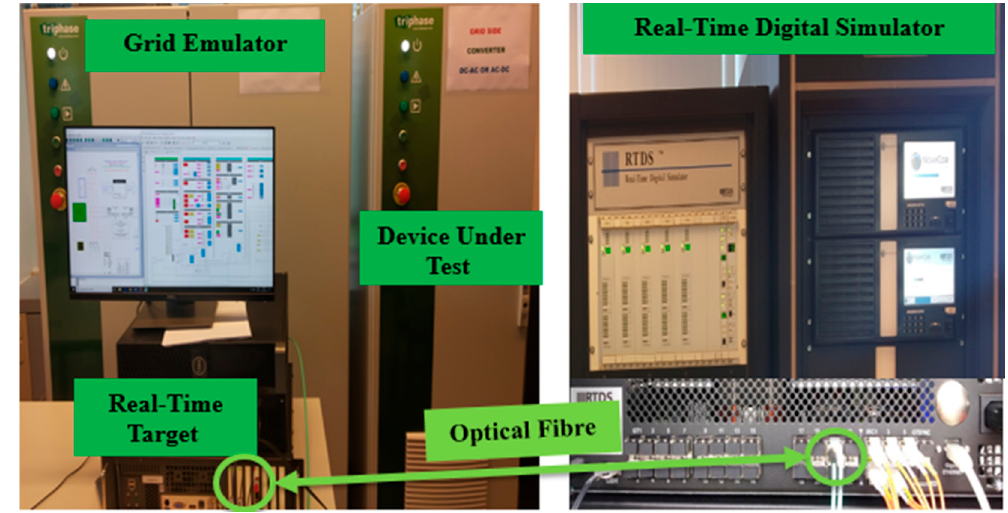
Figure 2. The power hardware-in-the-loop (PHIL) test setup.